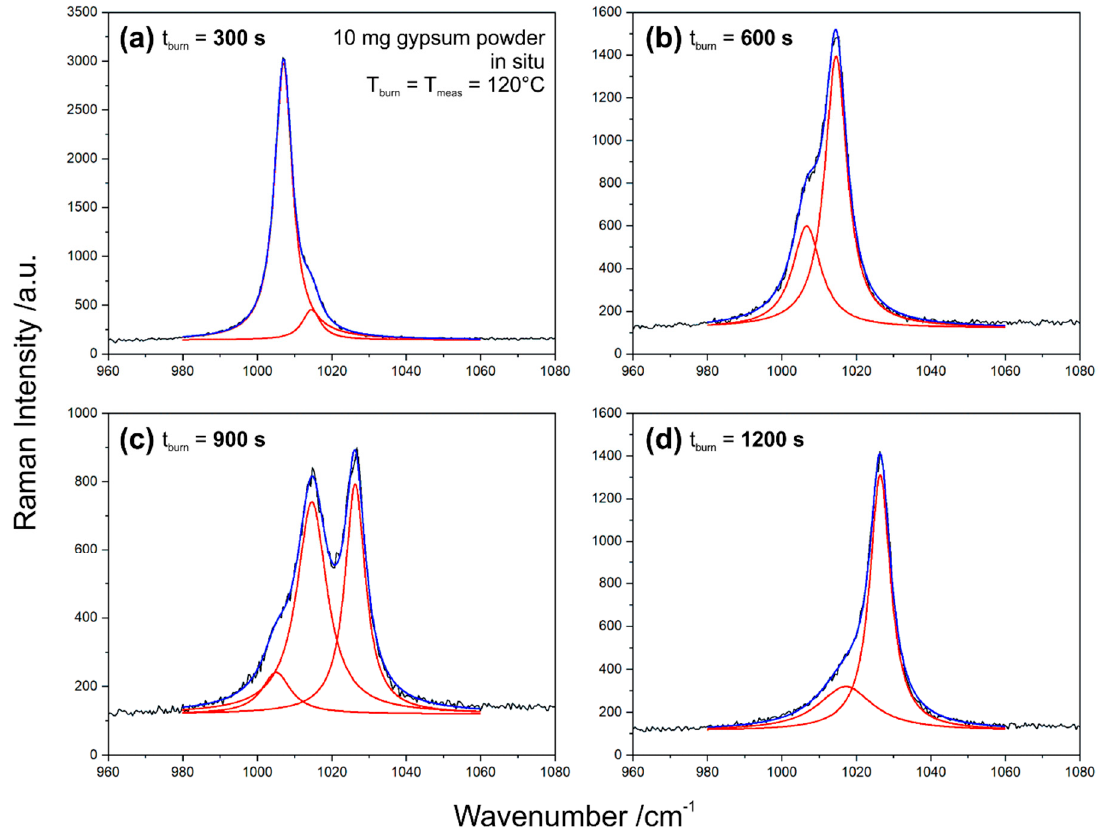
Figure 7. Selected spectra from the in situ Raman measurements shown in Figure 6 demonstrating their deconvolution into linear combinations of two or three Lorentzian peak profiles. The spectra were acquired at burning times t burn of ( a ) 300 s, ( b ) 600 s, ( c ) 900 s, and ( d ) 1200 s, respectively.